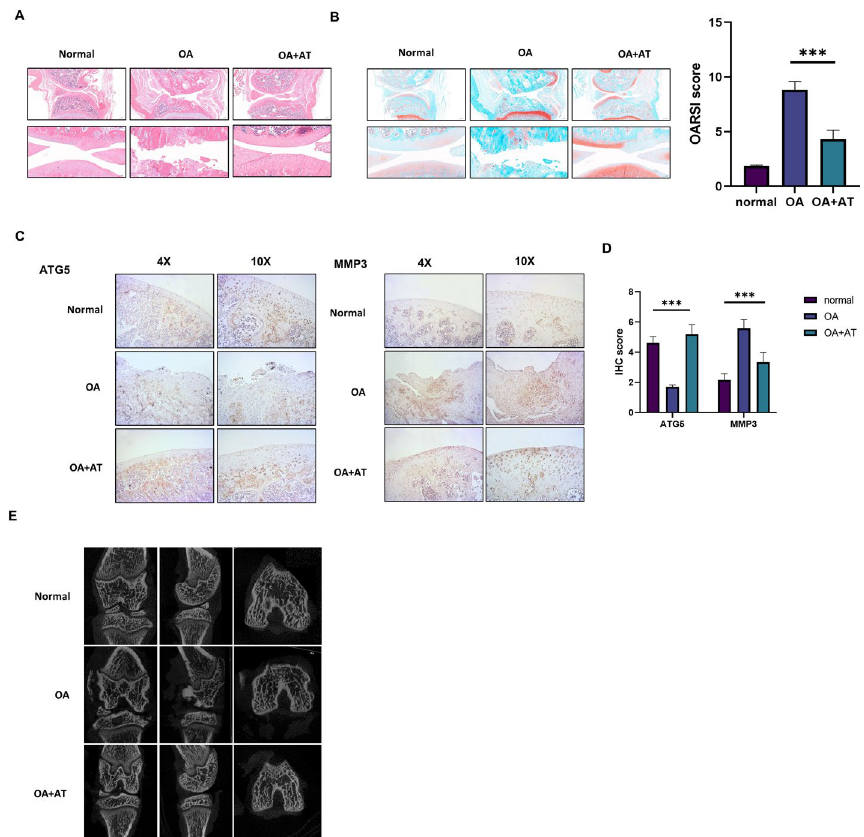
Fig. 6 Effect of AT on the treatment of OA in vivo. A and B Histological sections from knees ( n with HE and Safranin-O and associated OARSI scores. C and D Immunohistochemical staining of ATG5. Immunohistochemical staining of MMP3 and quantification of IHC scores. E Micro-CT was performed to scan the morphology of the knee joint. Normal group (injected with 0.1 mL PBS, n with 0.1 mL PBS, n 5), OA AT group (injected with 0.1 mL of AT, 20 μm, n = + mean SD ( n 5), *** P < ± =